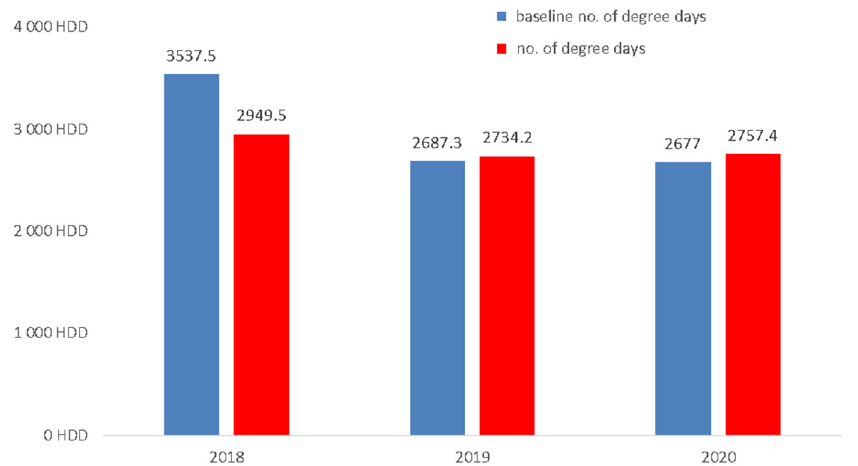
Figure 1. Number of heating degree days between 2018 and 2020.